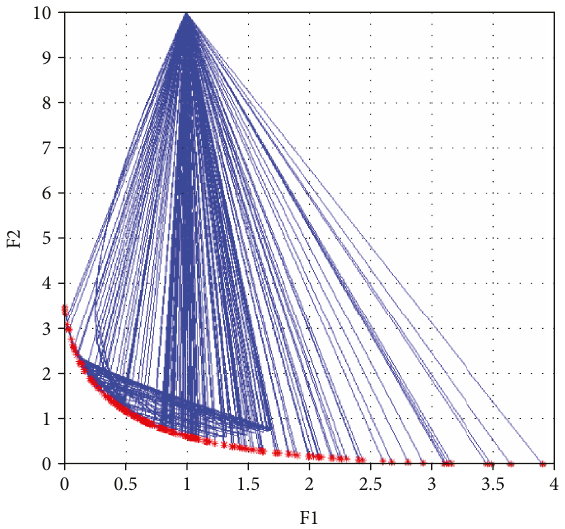
Figure 3: The Pareto optimal front of test 1 (random